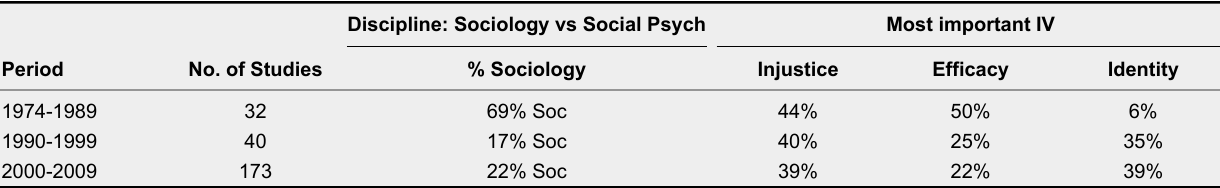
Paradigmatic development of the social psychology of protest from 1974-2009: Predictors